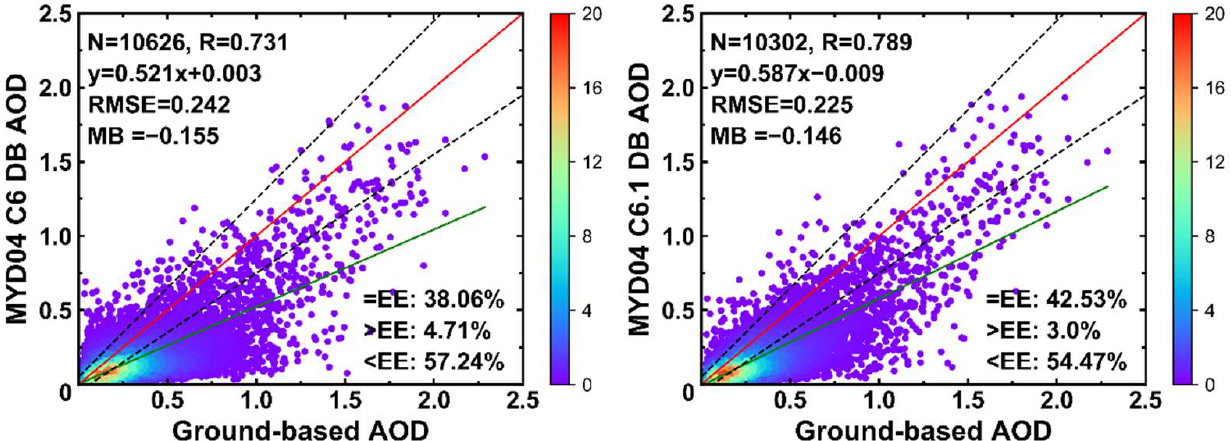
Figure 3. Validation of MODIS C6 ( left ) and C6.1 ( right ) DB AOD against ground-based AOD in Northwestern China. One-one line, linear regression line, and the EE envelopes of ±(0.05 + 20%AOD ground ) are plotted as red solid, green solid, and black dashed lines.